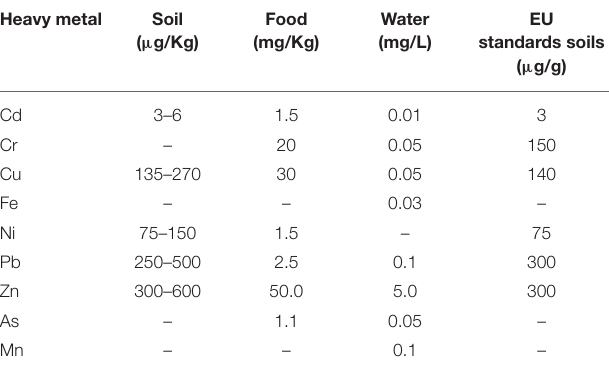
TABLE 2 | Indian and European standards (EU) standards for heavy metals in soil, food and drinking water (Source: Awashthi, 2000). Heavy